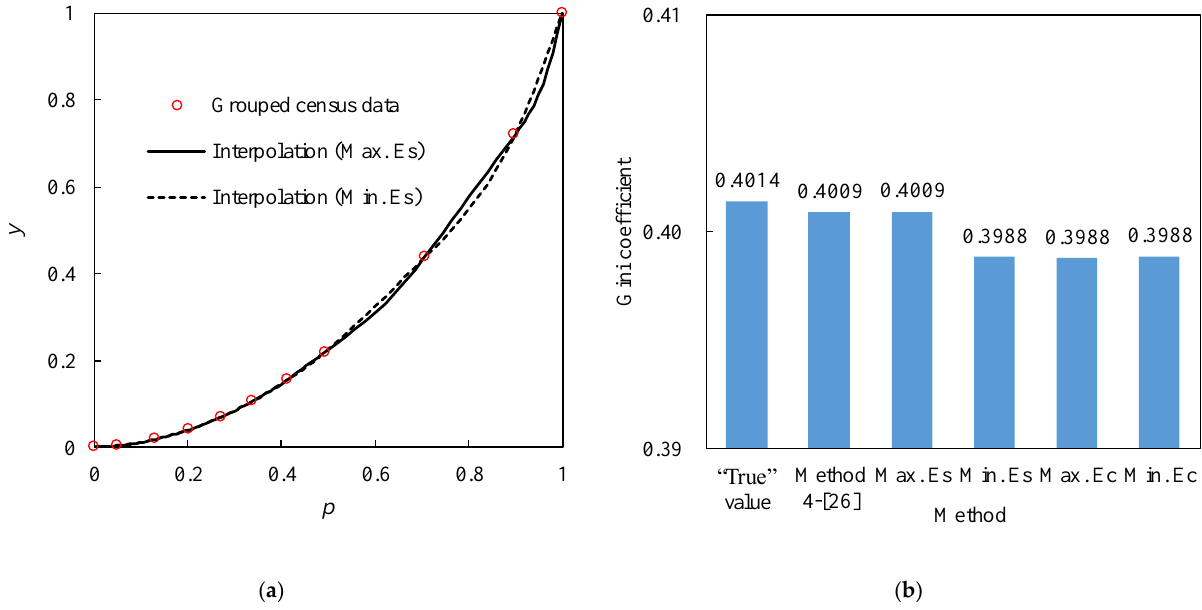
Figure 6. ( a ) Income data of 10 unequally spaced groups [10] and interpolated Lorenz curves based on maximization (Max. Es) or minimization (Min. Es) of approximated strain energy; ( b ) Comparison of Gini coefficients estimated with different methods.